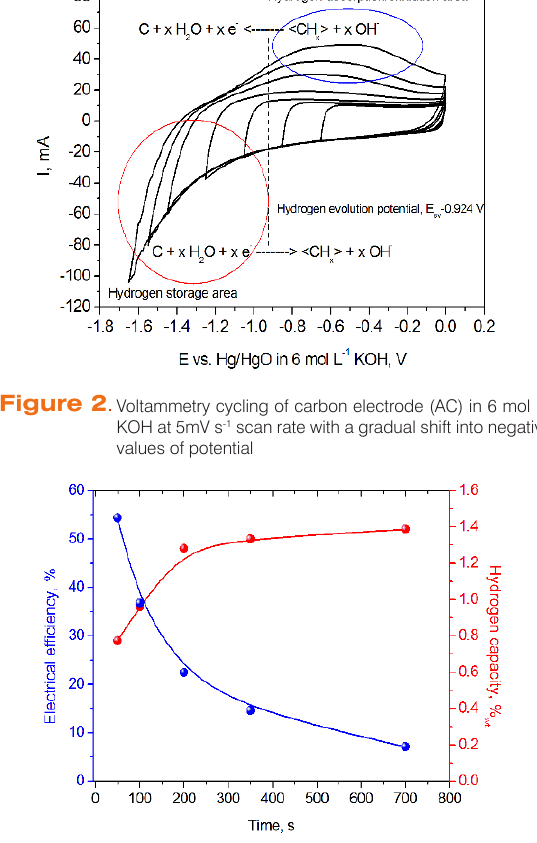
Figure 3. Hydrogen capacity and electrical efficiency during the fast charging with current of 32 A g -1 . Discharge cut-off potential: -0.25